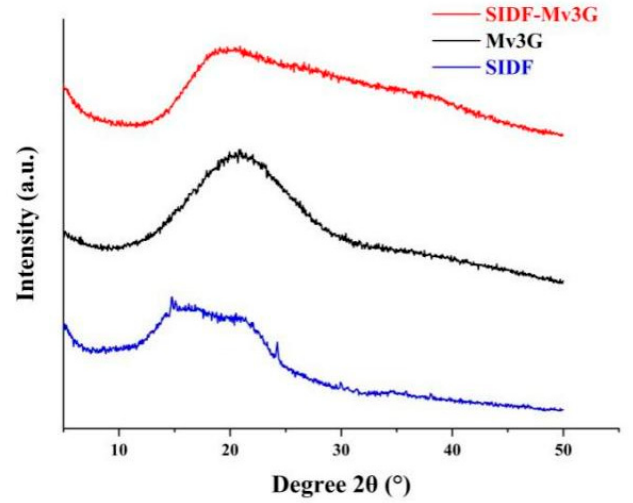
Figure 6. X-ray diffraction patterns. SIDF-Mv3G: the stability system of soybean insoluble dietary fiber and malvidin-3- O -glucoside; Mv3G: malvidin-3- O -glucoside; SIDF: soybean insoluble dietary fiber.